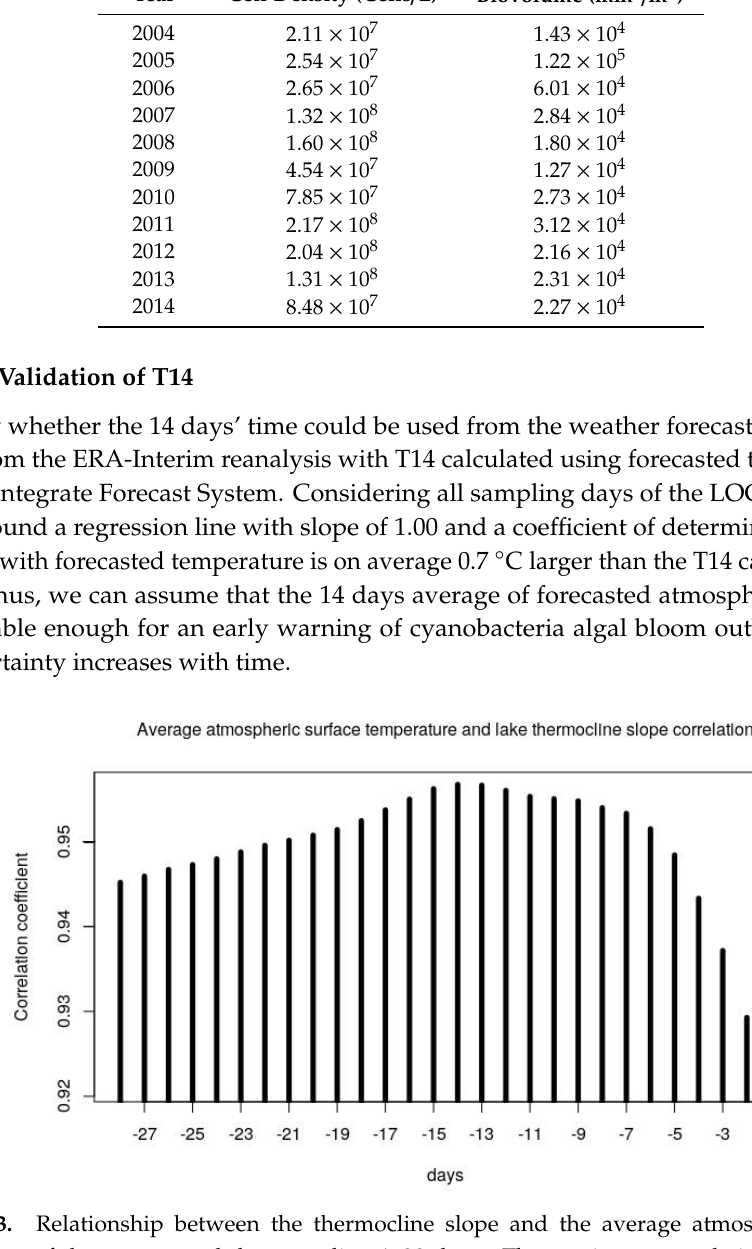
Table A2. Two-variable multiple linear regression (MLR) models of cyanobacteria biovolume (LOG CyanoBV) using the 14-days mean atmospheric temperature (T14) and one of the physical–chemical variables (AN: Ammonium nitrogen; CD: Conductivity; TP: Total phosphorous; SD: Secchi disk depth; RS: Reactive silicates; DO: Dissolved oxygen; OS: Saturation oxygen percentage; and pH). The statistical significance of each coefficient is indicated when below 0.05 ( p -values: ***: 0.001; **: 0.01; *: 0.05). For each model the coefficient of determination (R 2 ), the adjusted R 2 (R 2 adj), and the F statistic are reported. LOG means 10-based logarithm. No. Linear Model